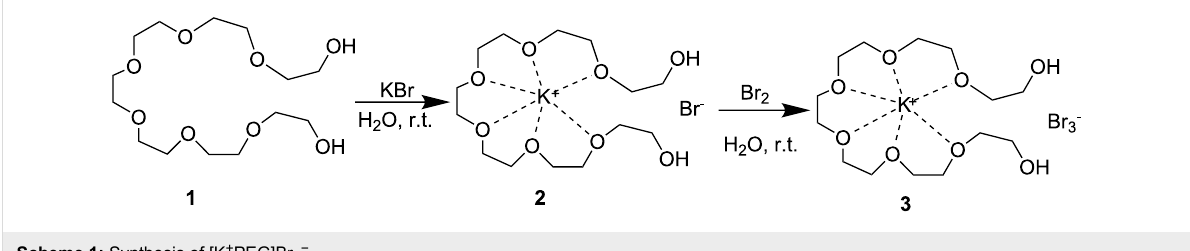
Scheme 1: Synthesis of [K + PEG]Br 3 − .